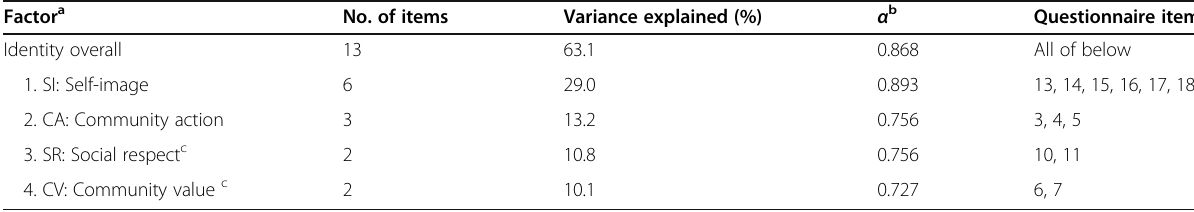
Table 1 Summary of the identity exploratory factor analysis Factor a No. of items Variance explained (%) α b Identity